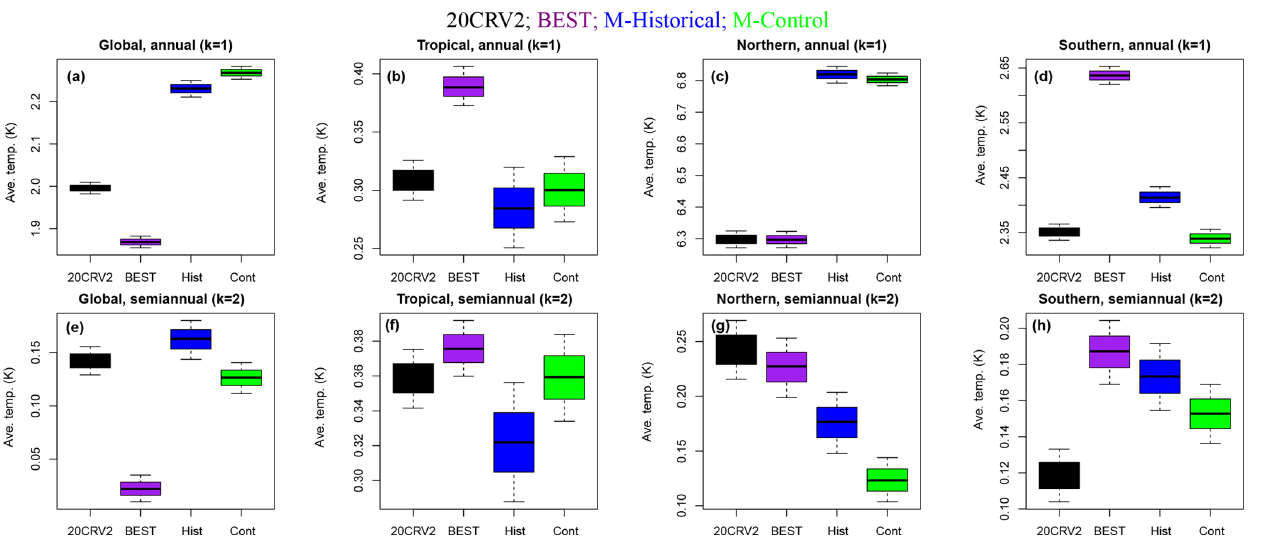
Figure 7. Same as in Fig. 3 but for the long-term analysis.